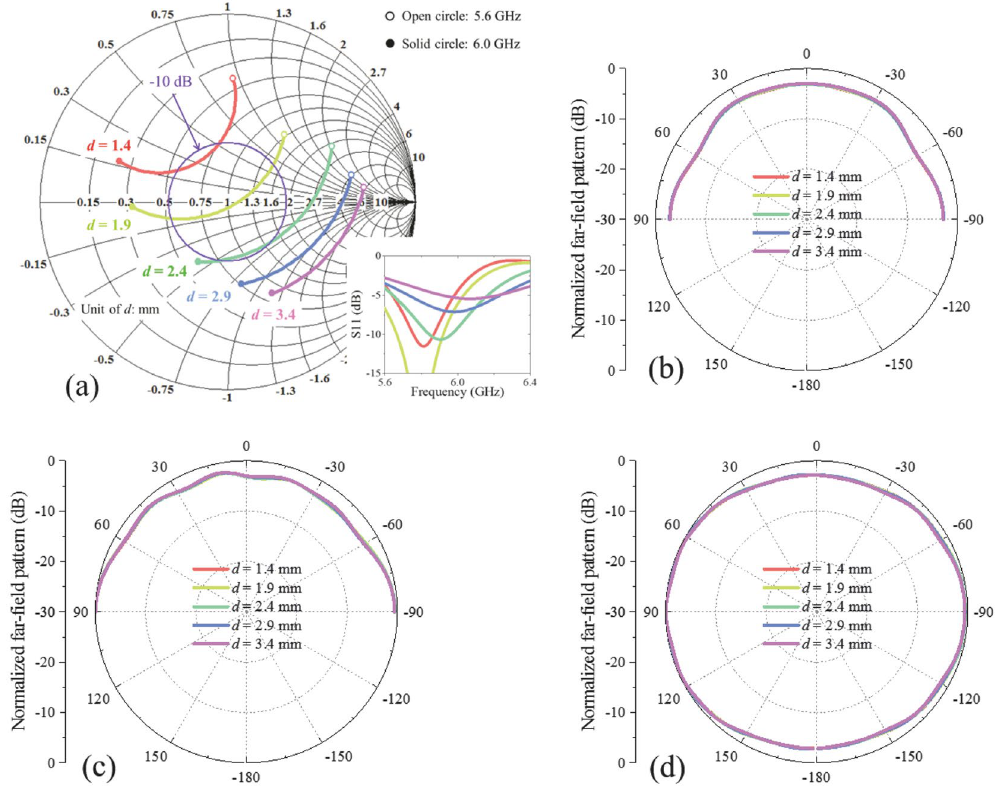
Figure 5. Relations between structure parameter d and antenna performances. ( a ) Impedance matching versus d . The insert figure shows reflection coefficients corresponding to different d . Normalized radiation patterns in xz plane, yz plane, and xy plane at 5.8 GHz versus d are shown in ( b – d ), respectively. Impedance changes a lot and radiation patterns change little with structure parameter d